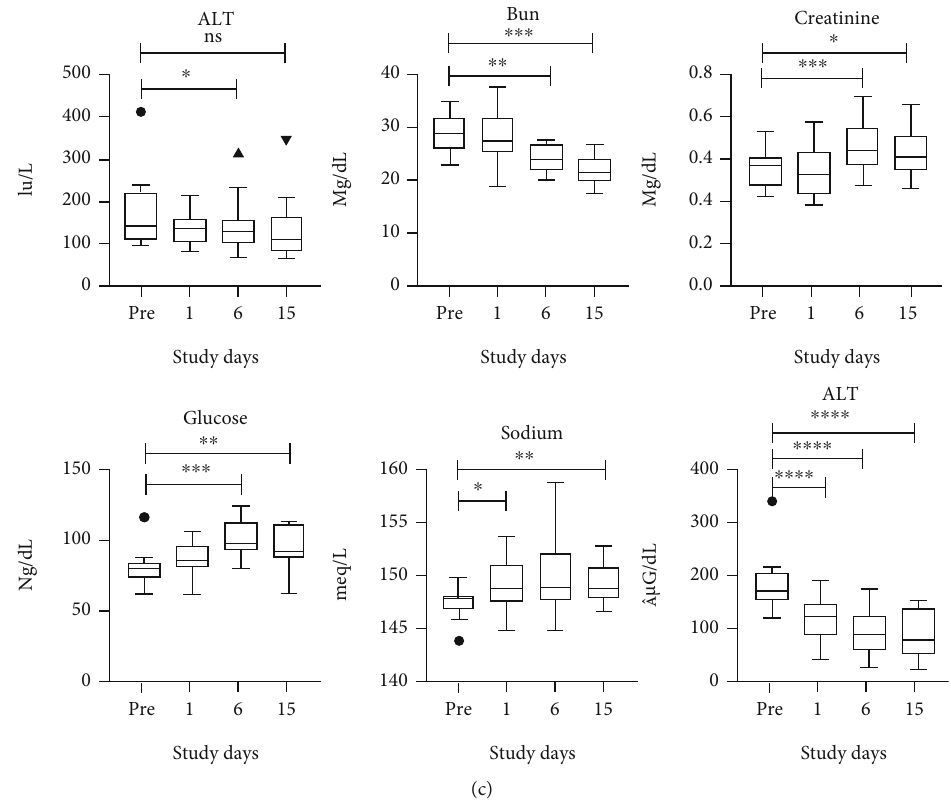
Figure 2: (a – c) Hematology and chemistry analysis. (a) Whole blood analyzed by using an automated analyzer ADVIA (Siemens Healthcare Diagnostics, Tarrytown, NY) at prerelocation and days 1, 6, and 15 postrelocation. Values on the y -axis are the absolute numbers of white blood cells (WBC), lymphocytes, monocytes, and neutrophils presented as 10 3 per μ L of whole blood. (b, c) The fresh serum samples were used for serum chemistry analysis on a Beckman Coulter AU680® Chemistry Analyzer. (b) Measurement of serum chemistry panels included the measure of triglycerides, total bilirubin, alkaline phosphate, total protein, CK, and globulin. (c) Measurement of ALT, BUN, creatinine,